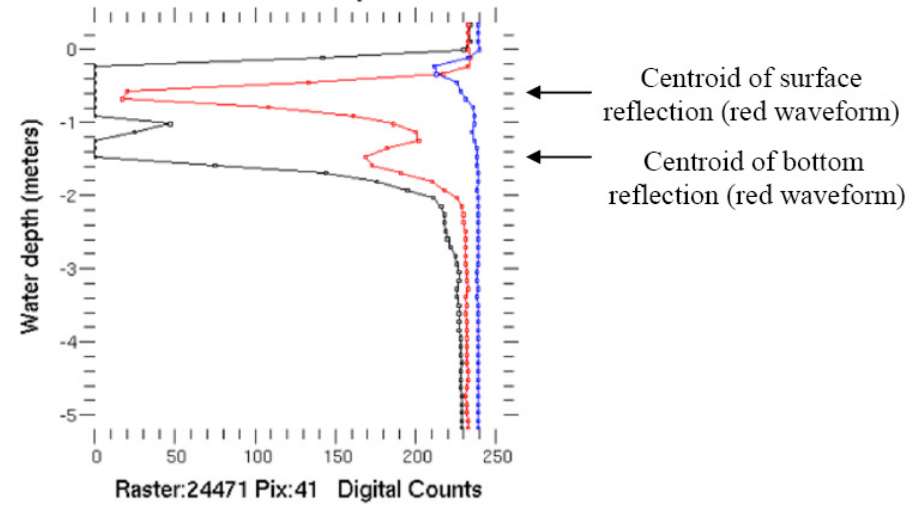
Figure 2. Typical bathymetric waveforms for three photo-detectors with a strong water surface reflection and weaker bottom reflection. Each detector independently records the time history of energy from each laser pulse. Here the three records are also plotted independently, and thus have small offsets on the vertical axis. Normally the offsets are removed during calibration. Digital counts are inverted in the photodetector and lower counts correspond to higher energy